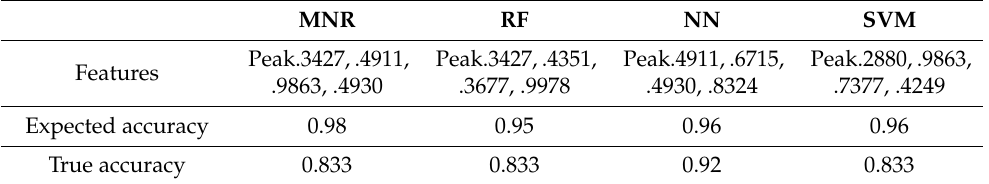
Table 2. Performance of optimized fine-tuned ML models trained on the top four features identified using a feature selection approach specific for Mulitnomial Logistic Regression (MNR), Random Forest (RF), Neural Network (NN), and Support Vector Machine (SVM), separately. The performance was evaluated in terms of expected and true accuracy for training CV folds and external test datasets, respectively. The top four features used to train the corresponding ML model were also included.